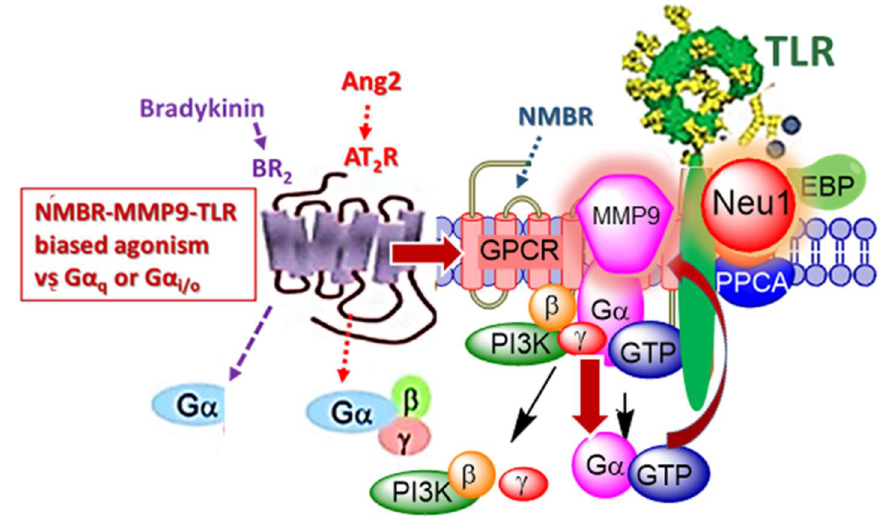
Figure 4. Bradykinin (BR2) and Angiotensin II receptor type I (AT2R) exist in a multimeric receptor complex with NMBR, IR β , and Neu1 in naïve (unstimulated) and stimulated RAW-blue macrophage cells. Here, a molecular link regulating the interaction and signaling mechanism(s) between these molecules on the cell surface uncover a biased GPCR agonist-induced cell surface and intracellular Toll-like receptor (TLR) transactivation-signaling axis, mediated by Neu1 sialidase and the glycosylation modification of TLRs. The biased GPCR-signaling platform here potentiates Neu1 and MMP-9 crosstalk on the cell surface that is essential for the transactivation of TLRs and subsequent cellular